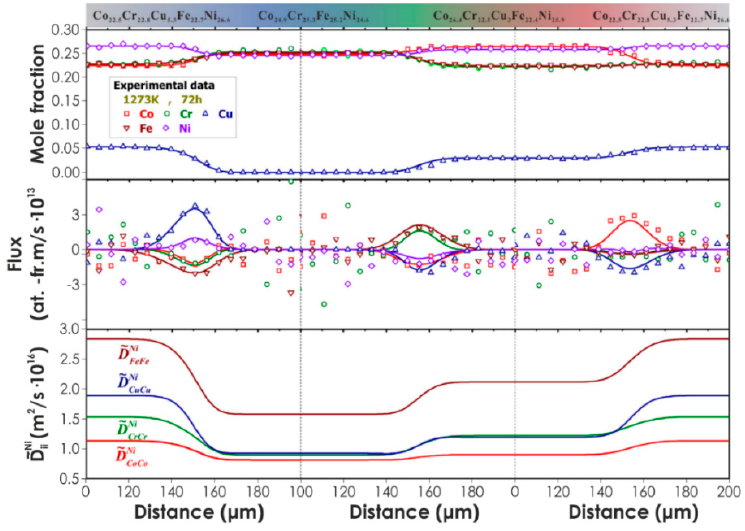
Figure 12. Comparisons of the model-predicted concentration/interdiffusion profiles with the corresponding experimental data (symbols), and the evaluated diagonal interdiffusivities along the diffusion paths of the diffusion multiples annealed at 1273 K for 72 h (after [37]). Reprinted from Journal of Materials Science & Technology 34 (2018), Experimental and numerical studies on the sluggish diffusion in face-centered cubic Co-Cr-Cu-Fe-Ni high-entropy alloys, 434–444, Copyright 2018, with permission from Elsevier.